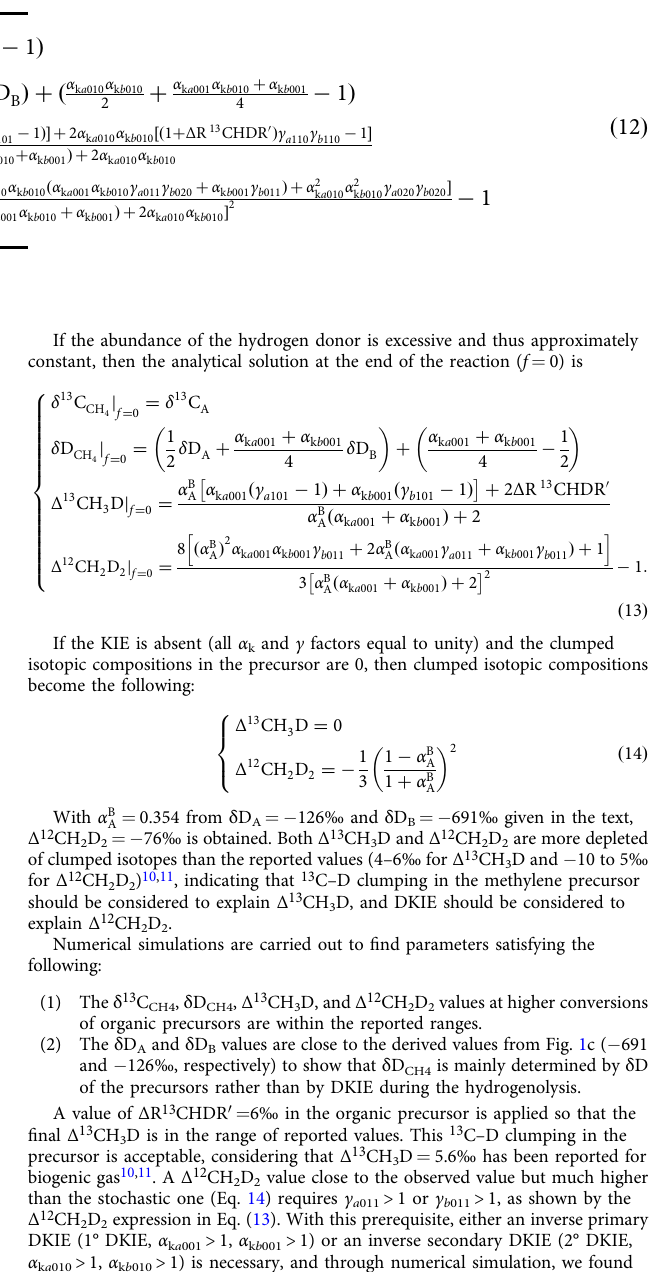
Model B: bulk and clumped isotopic fractionations of CH 4 . Conversion of methylene in a long C – C chain to methane is generalised into two